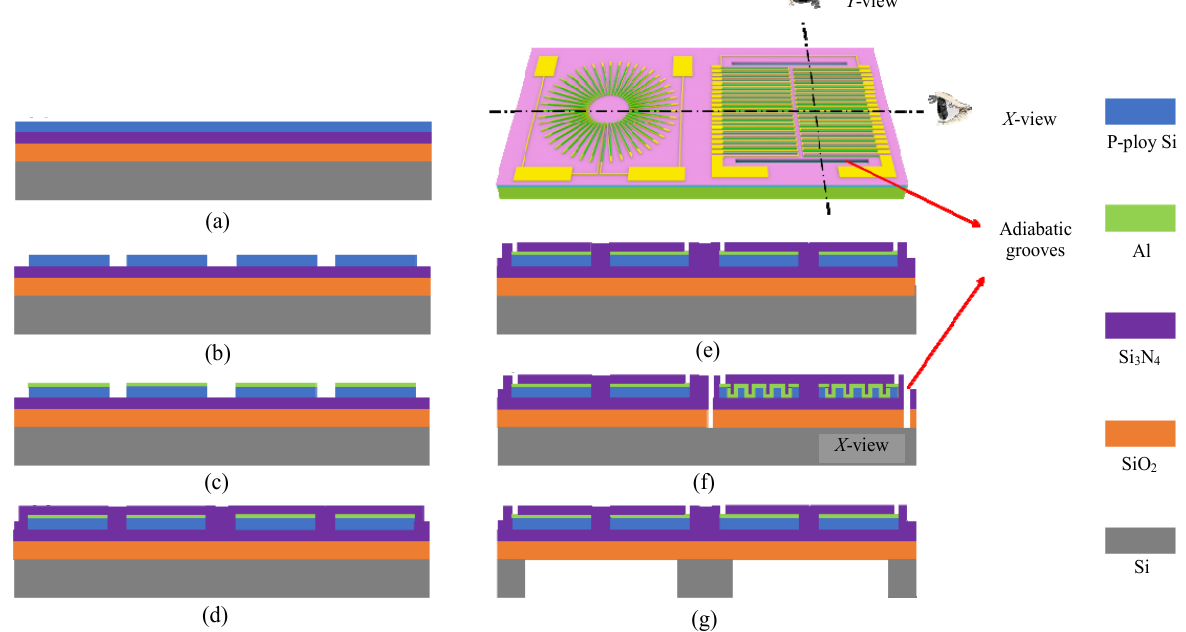
Fig. 4 MEMS infrared thermopile key preparation process: (a) preparation of composite support film layer and polysilicon, (b) etching to obtain polysilicon thermocouple strips, (c) deposition of metallic aluminum and etching to obtain aluminum thermocouple strips, (d) deposition of silicon nitride film layer for passivation absorption layer, (e) etching to expose the pads, (f) etching to prepare the adiabatic groove, and (h) deep silicon etching to release the